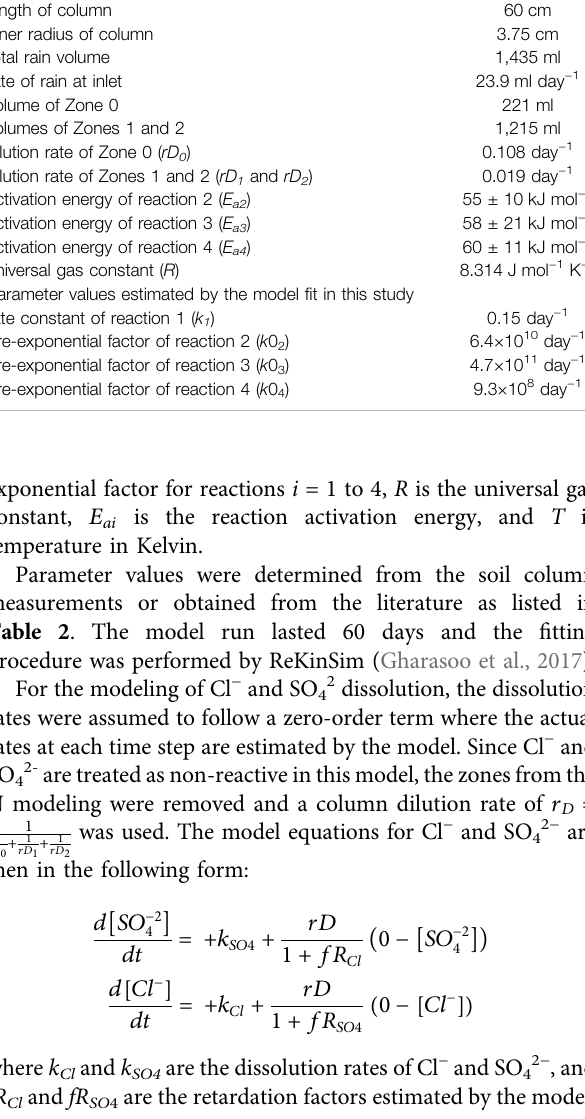
TABLE 2 | List of parameters values used for model simulation and estimated parameters from the optimization of Eq. 5 to the measured data. Reaction energies for the reactions 2, 3, and 4 were obtained from McKenney et al., 1984; Ambus, 1993; Saad and Conrad, 1993; and Maag et al., 1997. Parameter values derived from measurements, calculations, or literature values soil effective porosity ( ɸ